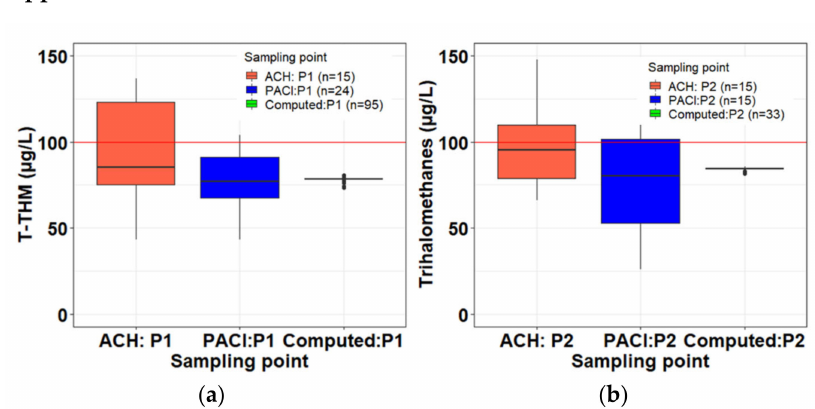
Figure A3. THMs in N-OKP and computed T-THM in EPANET: ( a ) Phase 1, ( b ) Phase 2. Table A2. THMs in N-OKP and computed in EPANET.